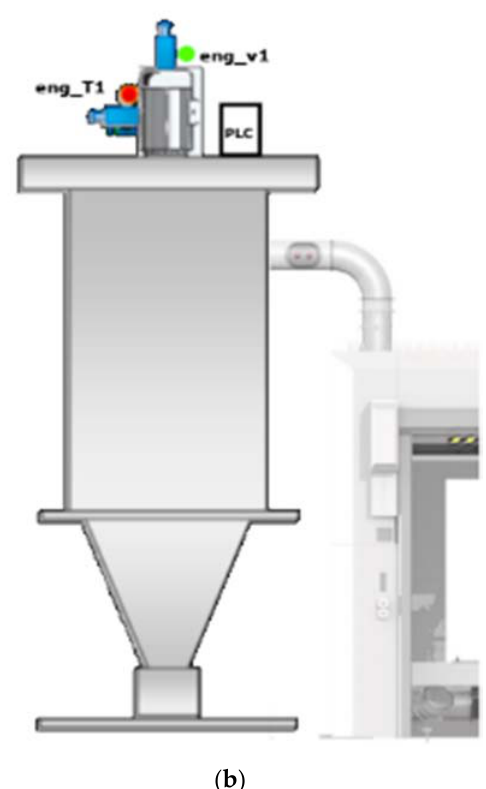
Figure 3. Example of a waterjet machine with the cyclone and sketch of sensors (red and green circles). ( a ) Waterjet machine. ( b ) Sensors placement sketch. Table 2. Cyclone features. Variables gathered per manufacturing